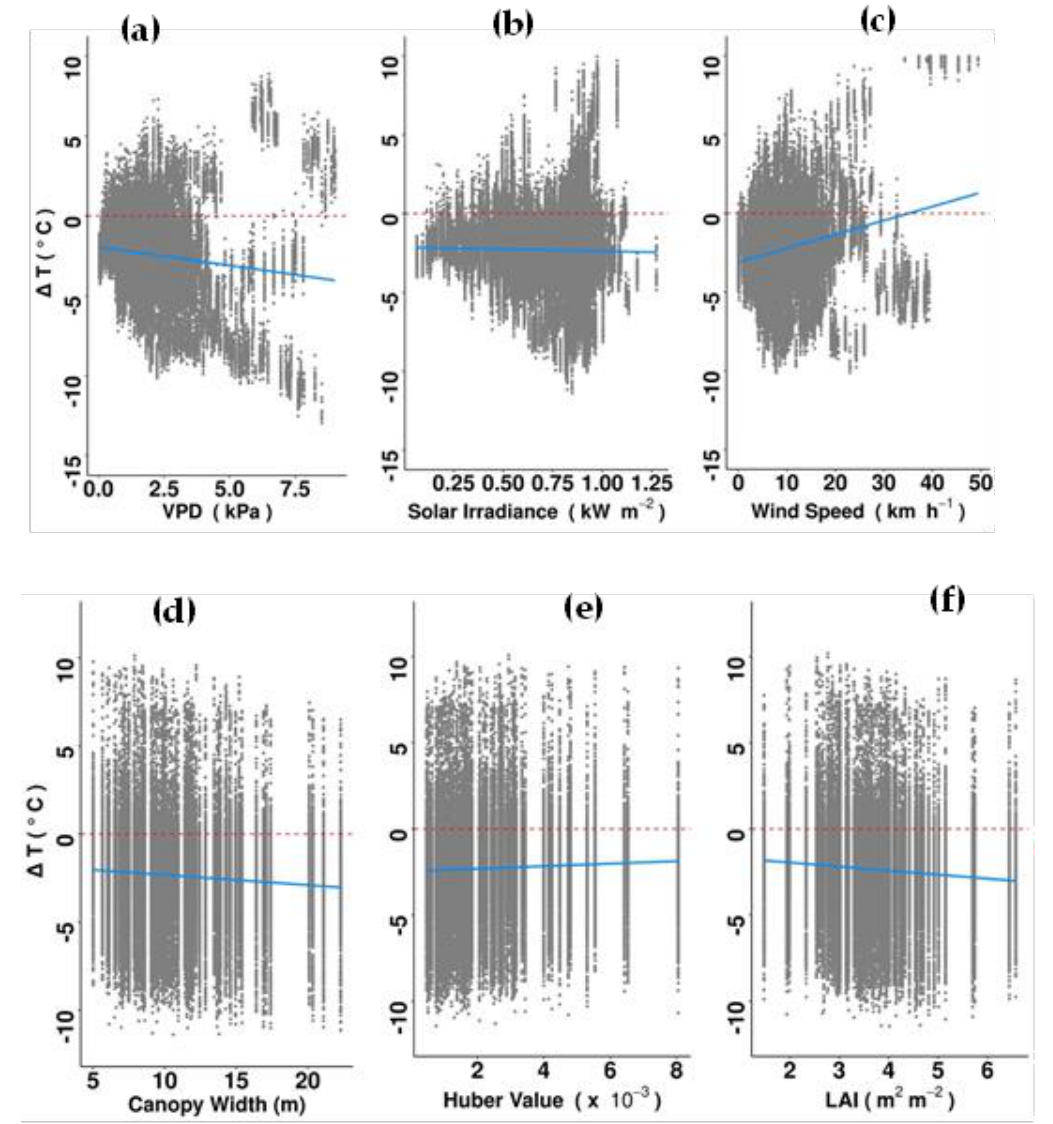
Figure 5. Relationship between Δ T and ( a ) vapor pressure deficit (VPD), ( b ) solar irradiance, ( c ) wind speed, ( d ) canopy width, ( e ) Huber value and ( f ) leaf area index (LAI) in the morning (07:00 to 13:00 h), using all recorded data from 96 individual trees over a three-month period. Total number of observations was 127,822. The dashed red lines indicate no difference between the canopy and ambient air temperatures and solid blue lines indicate best-fit trend predictions. Only significant relationships are shown. For detailed results of the lmer model see Supplementary Table S2.